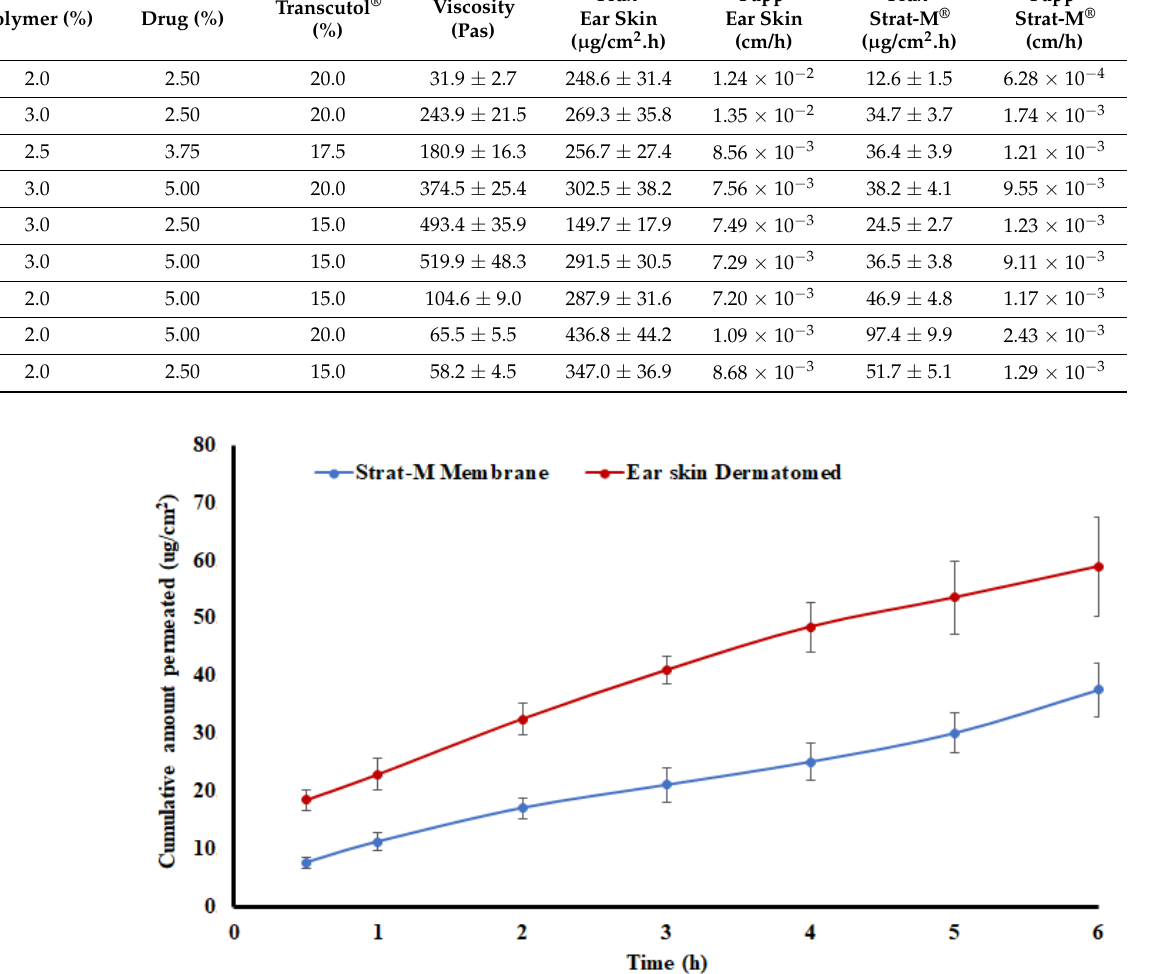
Figure 2. Permeation of saturated solution of desloratadine (in phosphate buffer pH 7.4) through Strat-M ® and pig ear skin. Data are shown as mean ± SD, n = 6.